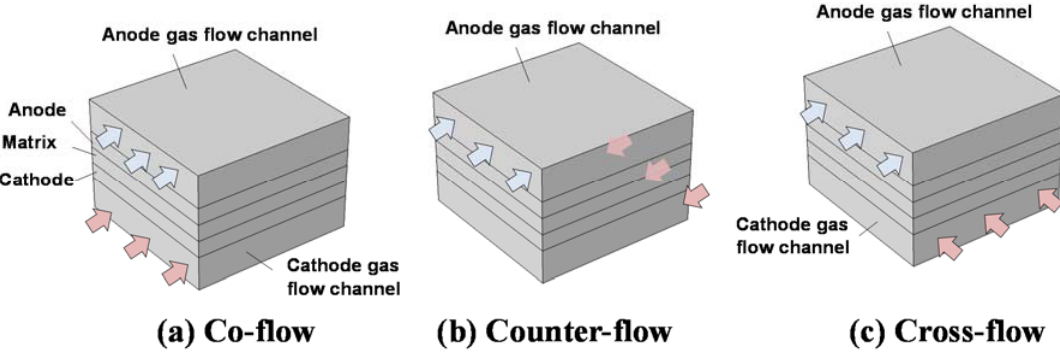
Figure 2. Flow types of molten carbonate fuel cells.